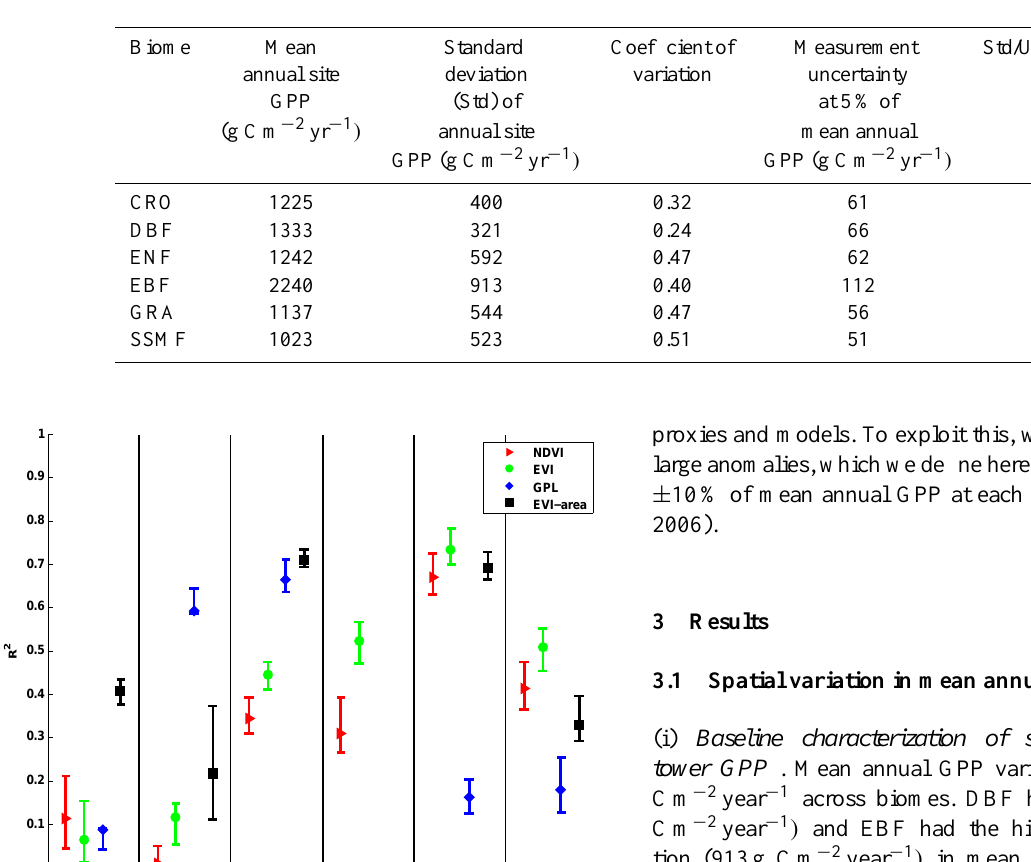
Table 3. Baseline statistics for annual tower GPP across sites in different biomes.